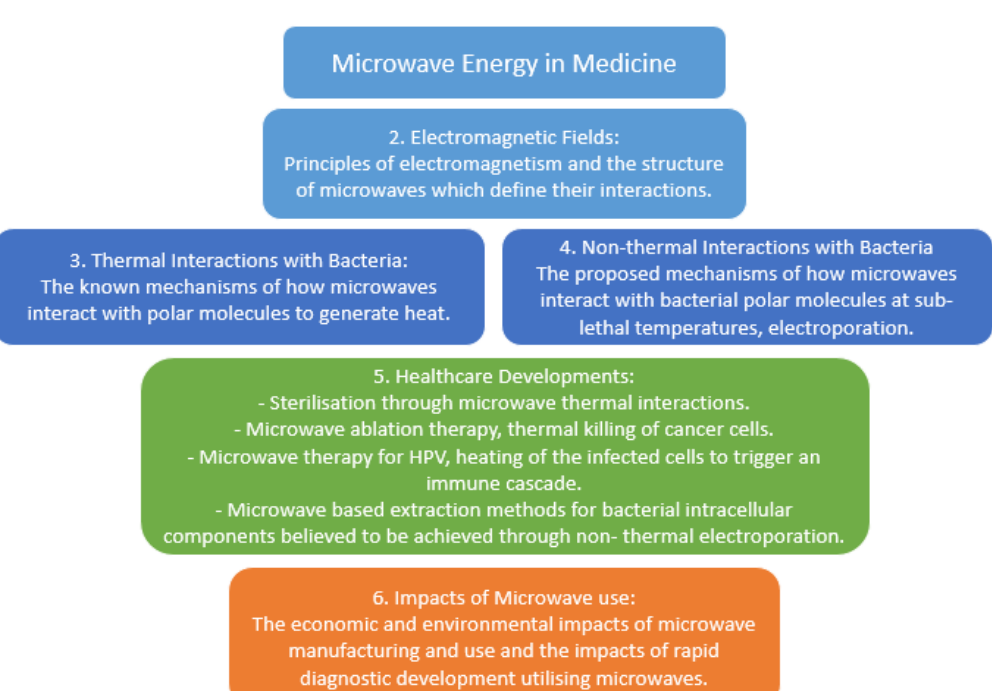
Figure 1. Electromagnetic spectrum. A depiction of the range of frequencies and wavelengths in the electromagnetic spectrum and the sub-ranges, as the wavelength increases the energy of the wave decreases [1].